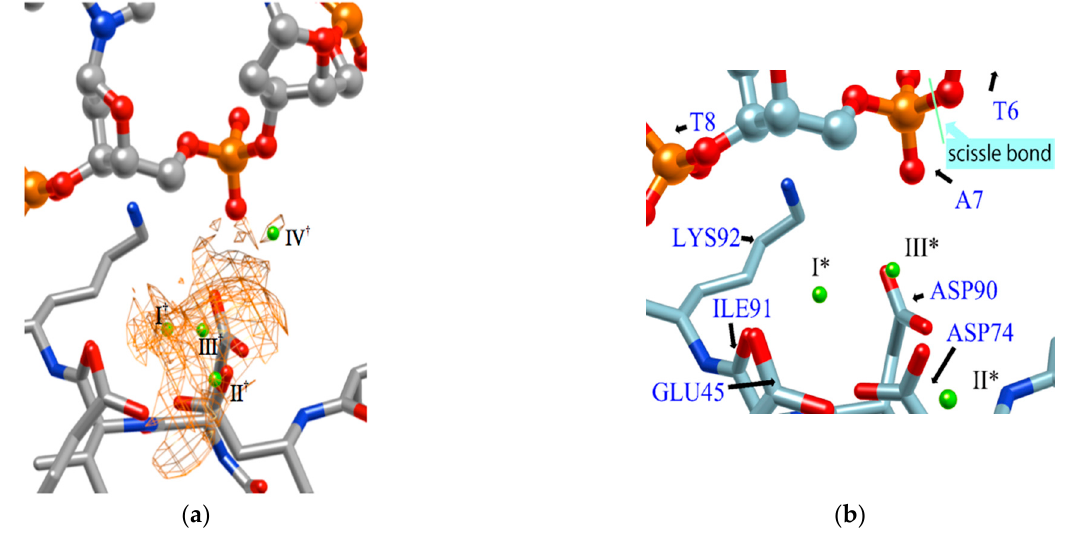
Figure 7. The 3D-distribution (g( r )) of ions in the Eco RV–DNA complex: ( a ) 3D-RISM/KH calculation, ( b ) Experimental results (Ref. [68]). (The figure is reprinted from Ref. [69]. Copyright (2018) American Chemical Society.).